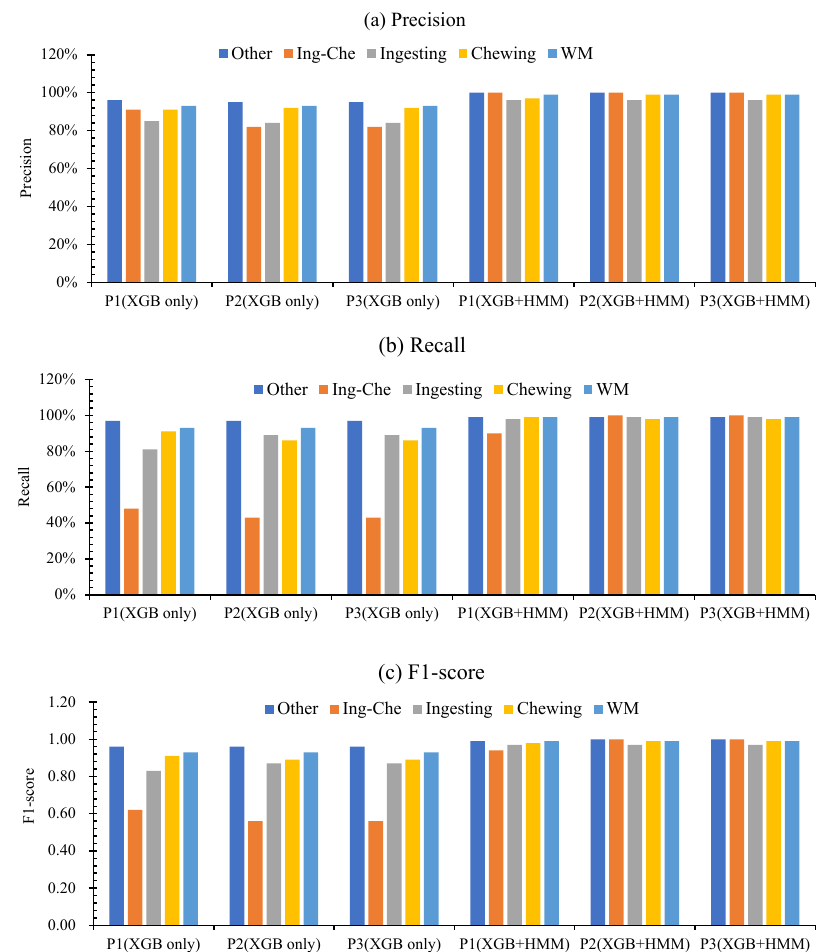
Figure 8. ( a ) The precision (unit: %) of activity identification at different monitoring sites at a window size of 10 s; ( b ) the recall (unit: %) of activity identification at different monitoring sites at a window size of 10 s; ( c ) the F1-score (dimensionless, range from 0 to 1) of activity identification at different monitoring sites at a window size of 10 s.